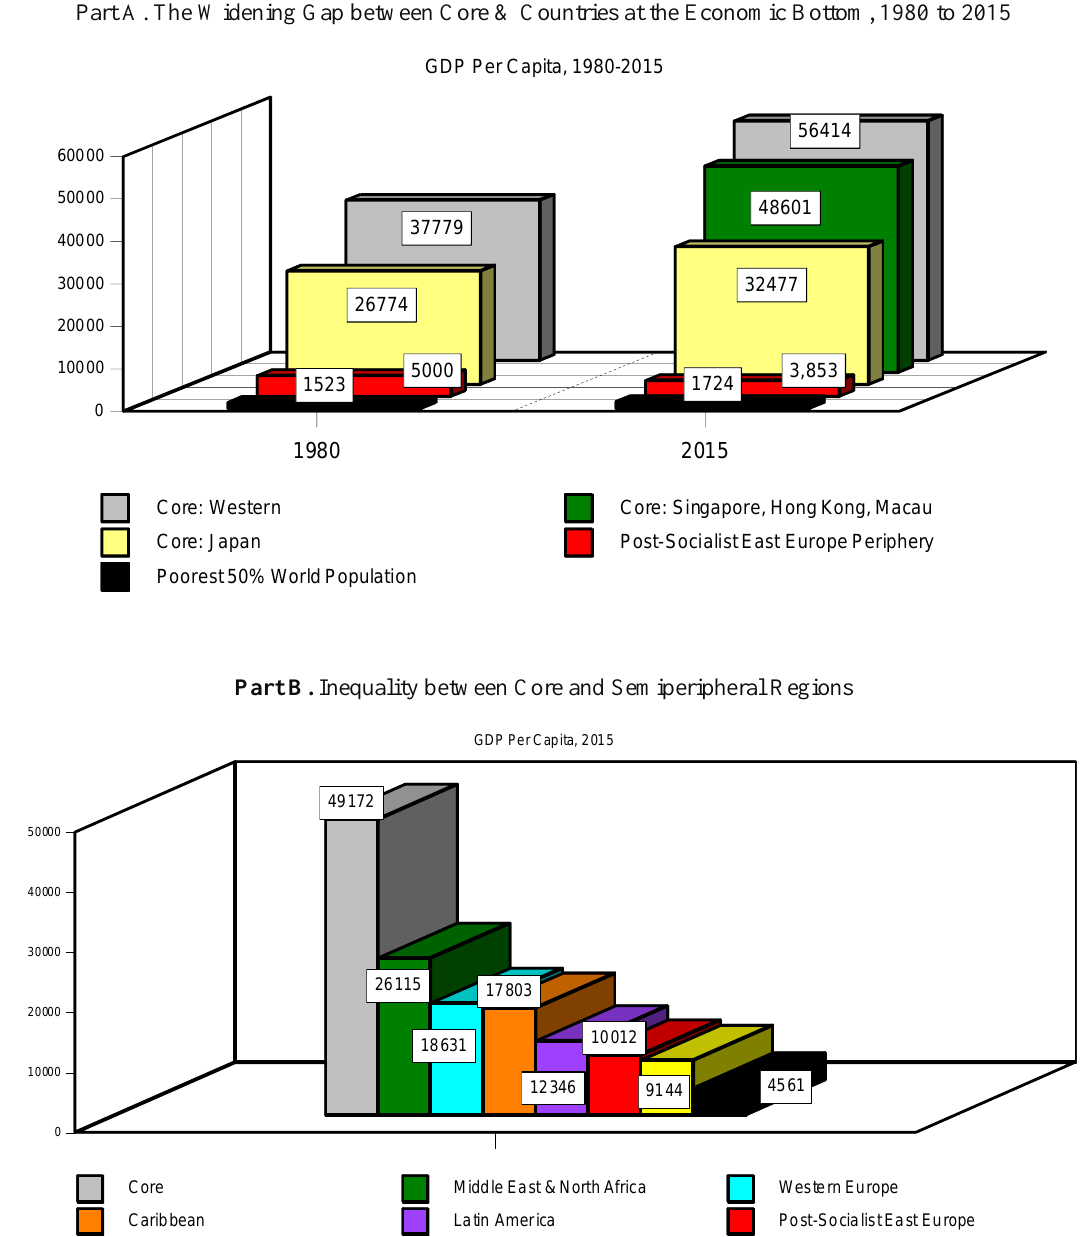
Figure 2. Inequality between Core, Semiperiphery and Periphery, 2015 Part A. The Widening Gap between Core & Countries at the Economic Bottom, 1980 to 2015